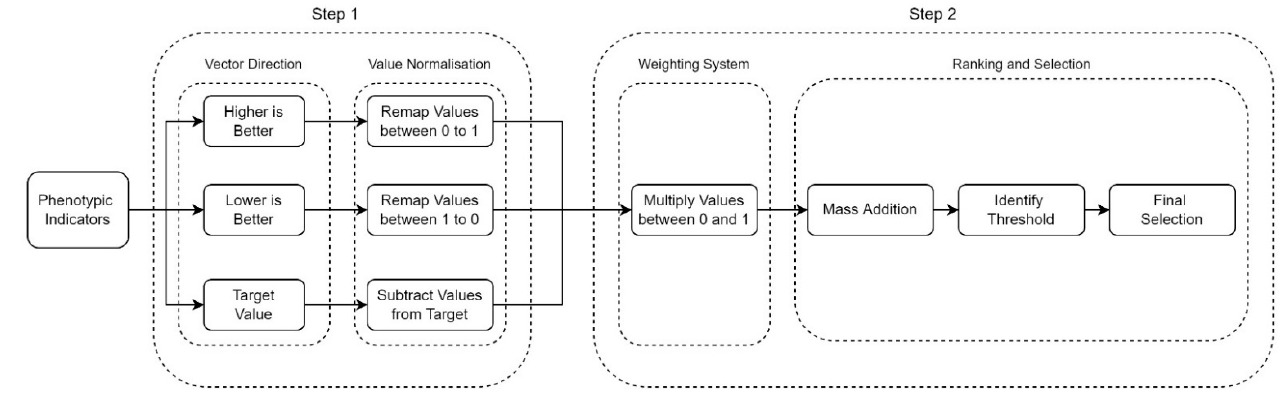
Figure 6. Pseudo code for Stage 2 of the selection framework.